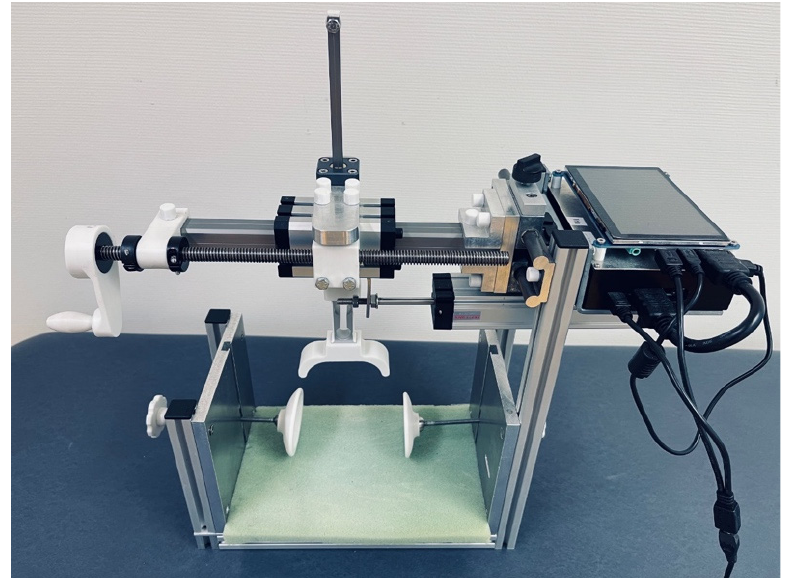
Figure 1. Patellostabilometer: knee pad in green, side stabilizers, grip arm and handle in white, metal crank, frame, sliders, LCD screen and the ports on the right, as described.